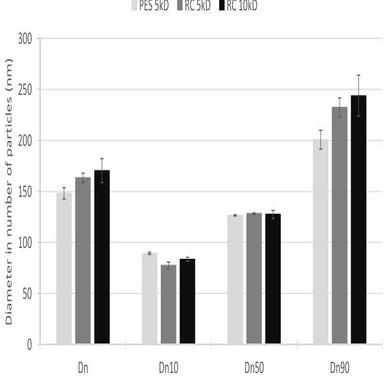
Average diameter (Dn) and distribution diameters (Dn10, Dn50 and Dn90) obtained by AF4-MALS for loaded formulation with PES 5 kDa (in light grey), RC 5 kDa (in deep grey), and RC 10 kDa (in black) membranes.